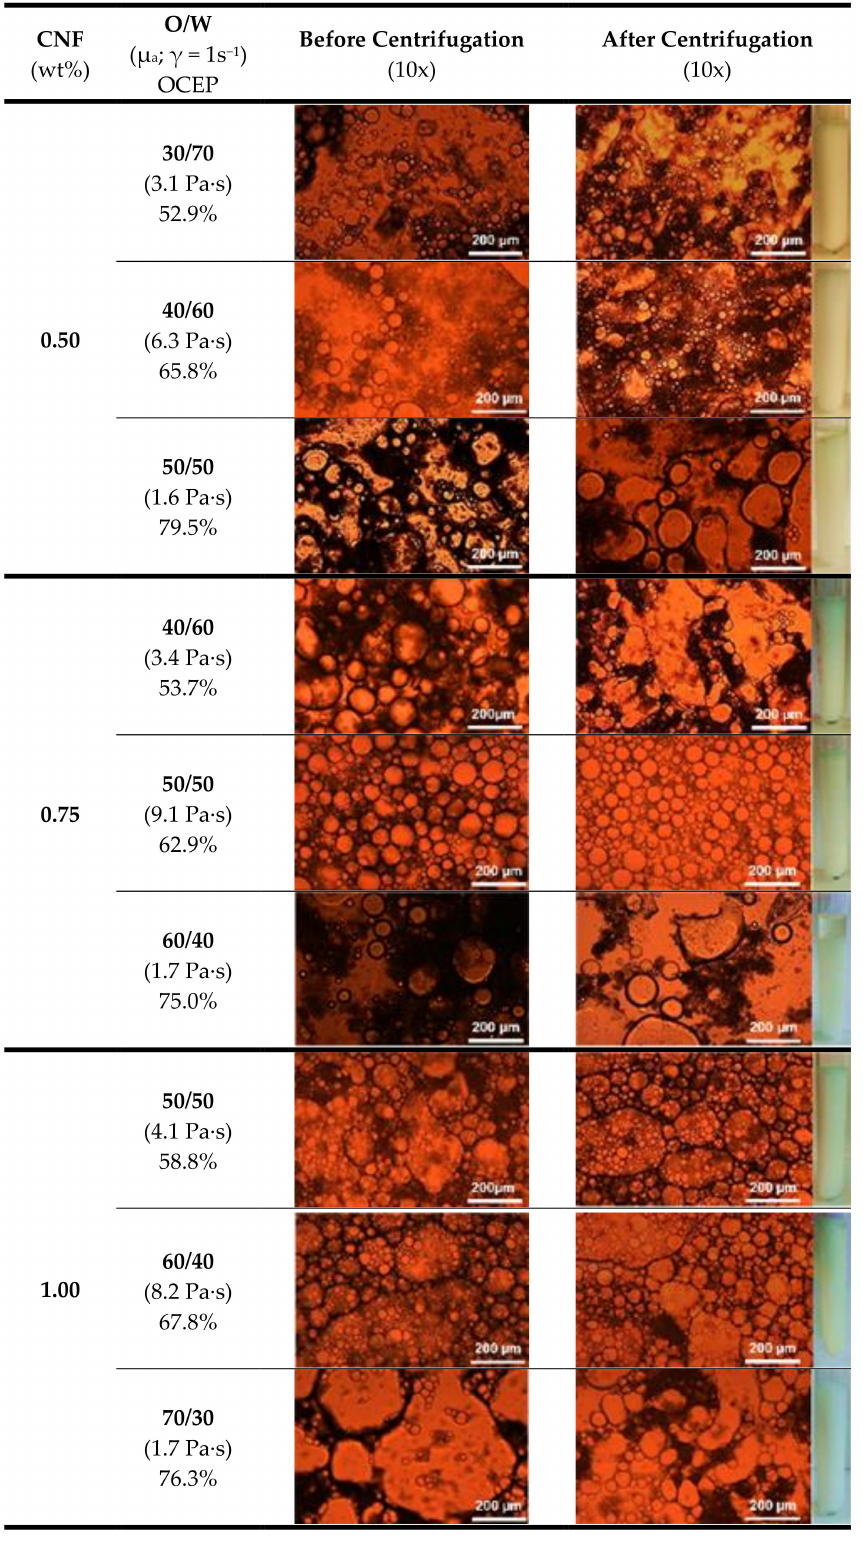
Figure 8. Microscope images and test tubes for several CMF